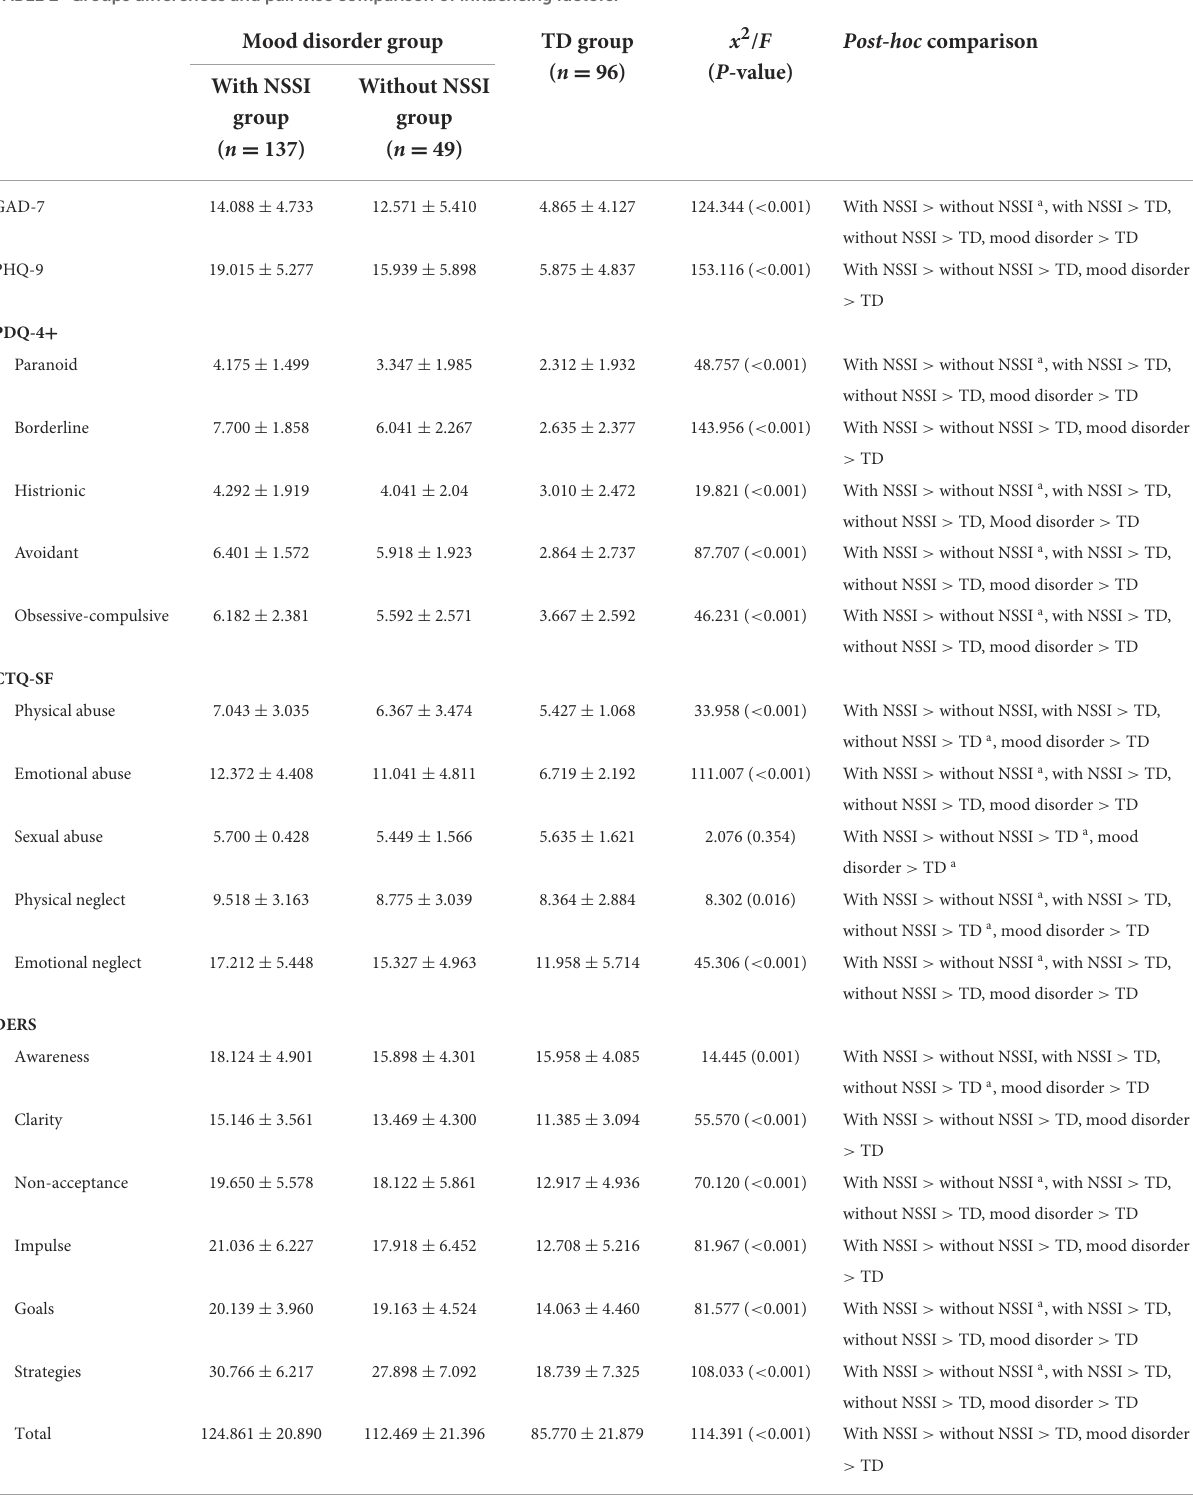
TABLE 2 Groups differences and pairwise comparison of influencing